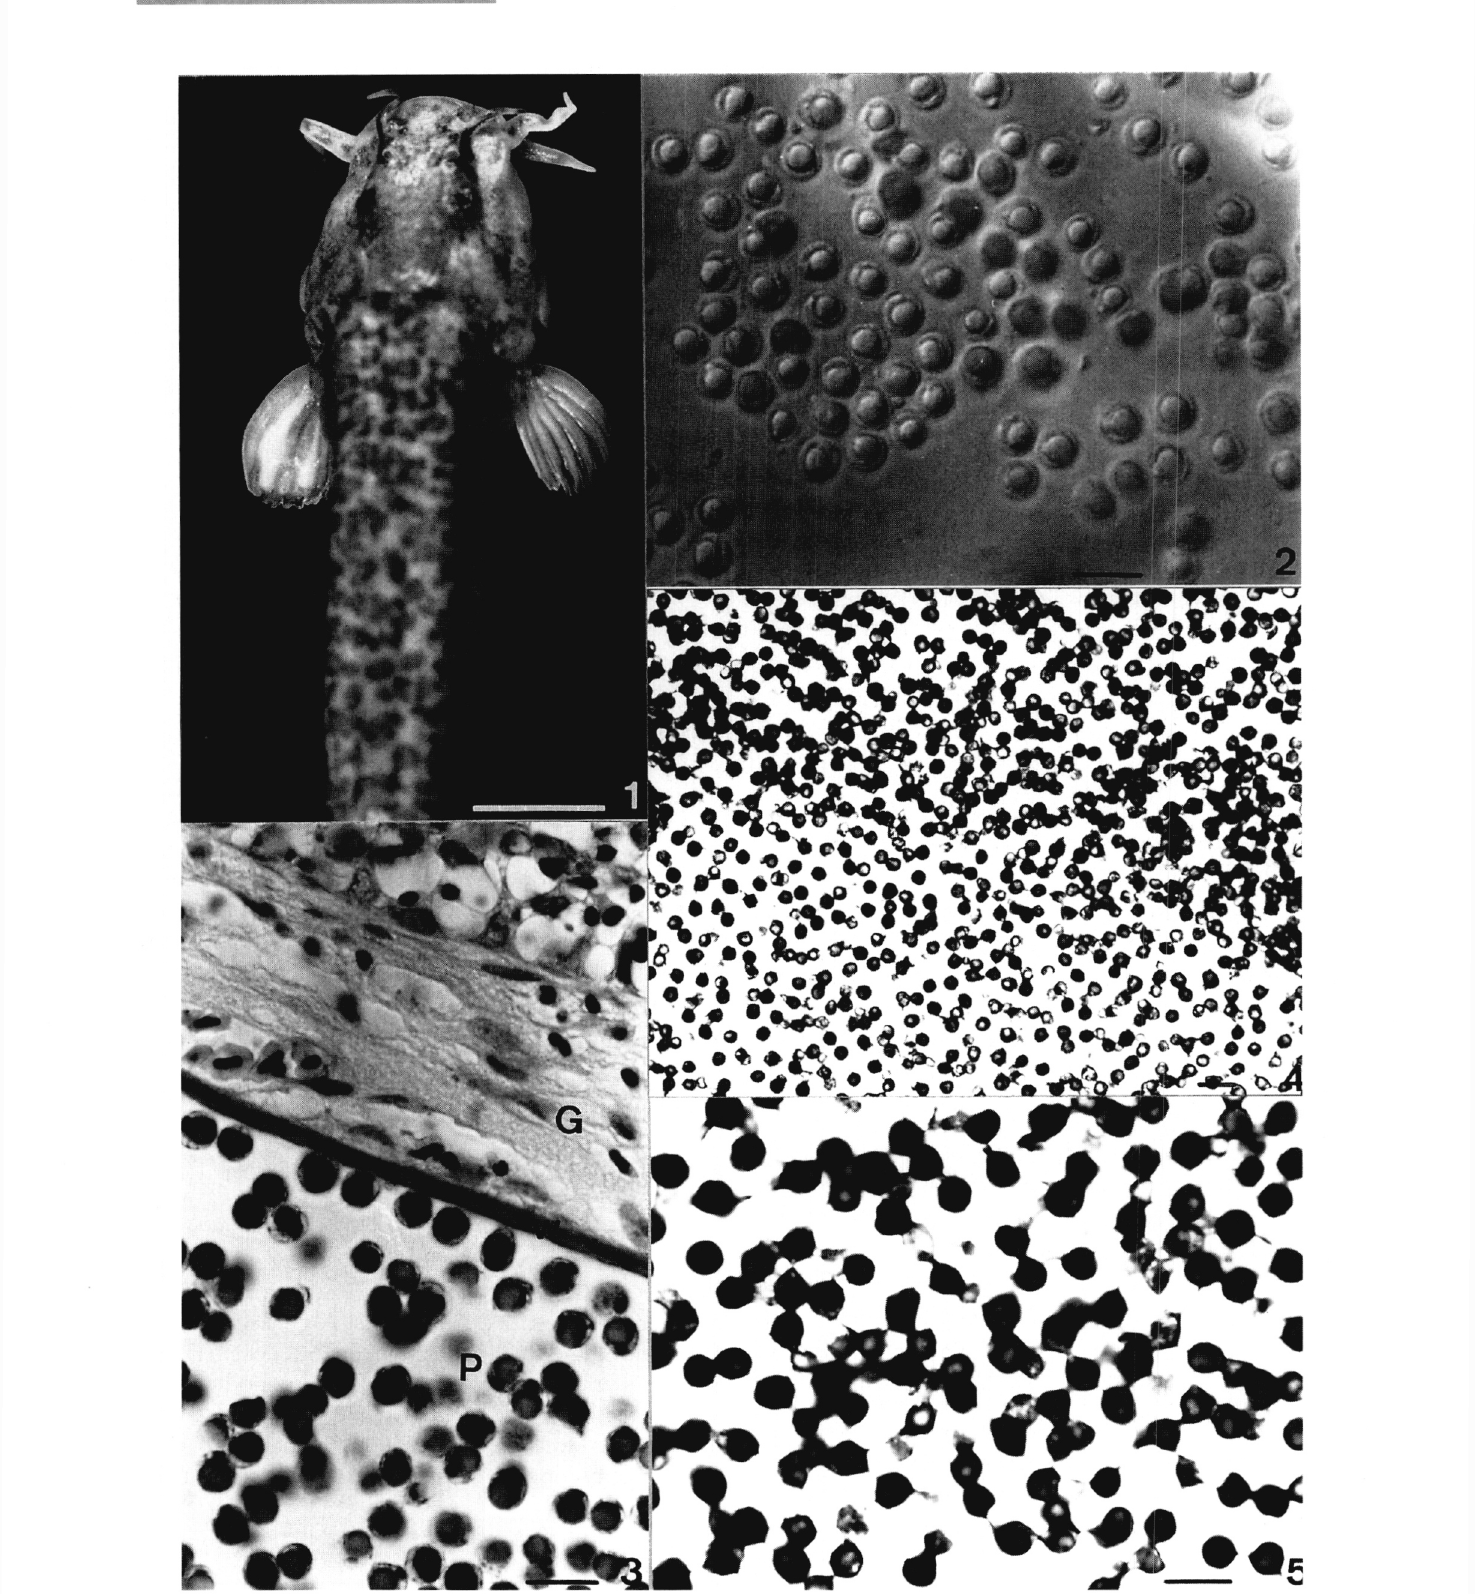
Fig. 1-5. - Infection of Trichomycterus sp. by Dermocystidium sp. 1 - Trichomycterus sp. Note the two whitish, elongate cysts in the left pectoral fin (bar = 3 mm); 2 - Dermocystidium sp. spores (fixed material). Nomarski phase contrast (bar = 10 μm); 3 - Details of the cyst. Note the cyst wall (w) and the fine granular material in the dermis (g). The parasitic cells (p) show a large central body (H & E, bar = 10 μm); 4 - Section of the cyst showing two types of spores, smaller (s) and larger (1) (H & E, bar = 10 μm); 5 - Formations apparently composed by the condensation of fine granular material (PAS, bar = 10 μm).